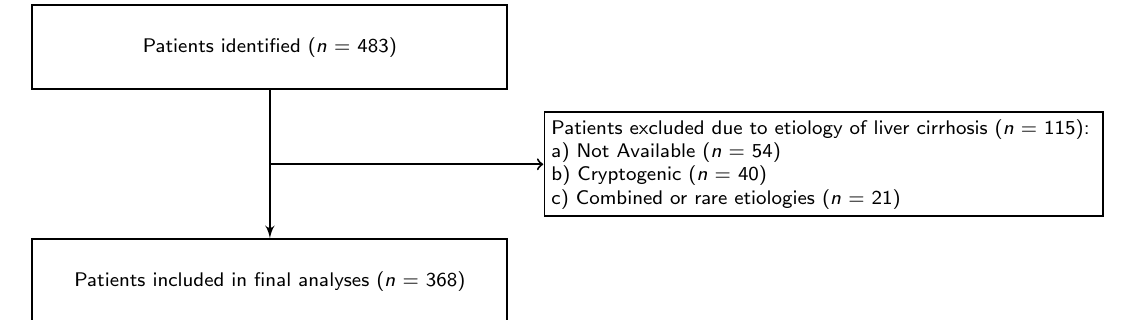
Figure 1. Flowchart of patient